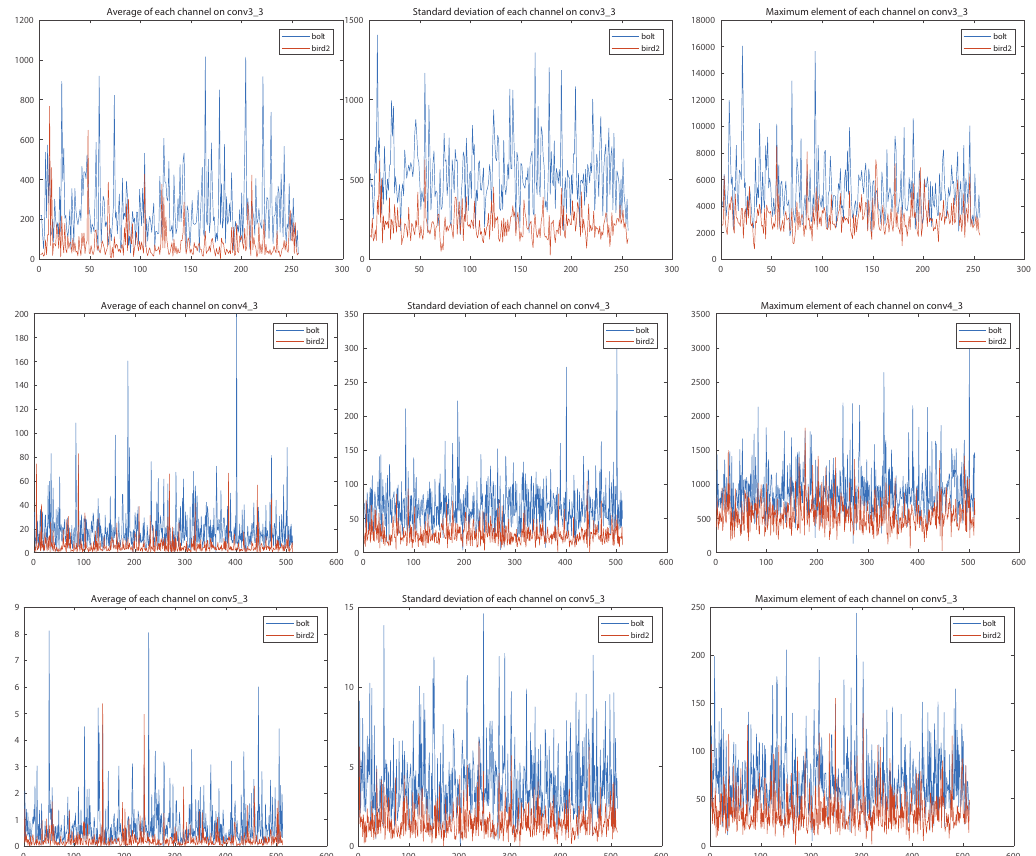
Figure 4. Visualizations of numeric distribution at different abstraction levels on two sequences. High-level abstractions ( bottom row) emerge with smaller values compared with low-level abstractions ( top row). It is unreasonable to directly add the features of different convolutional layers together. The limited training samples and epochs cannot afford enough learning procedure to obtain the appropriate model parameters. Results are best viewed on high-resolution